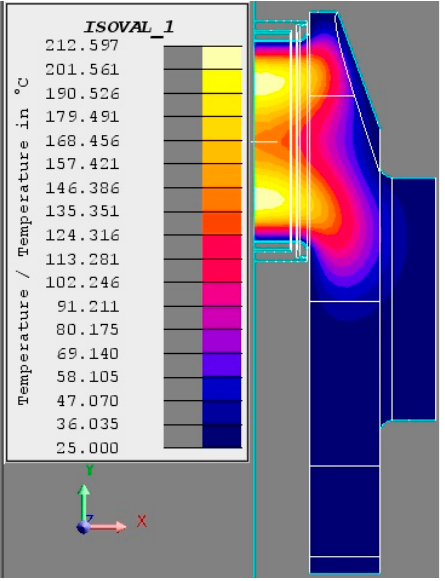
Figure 9. The temperature field after liquid